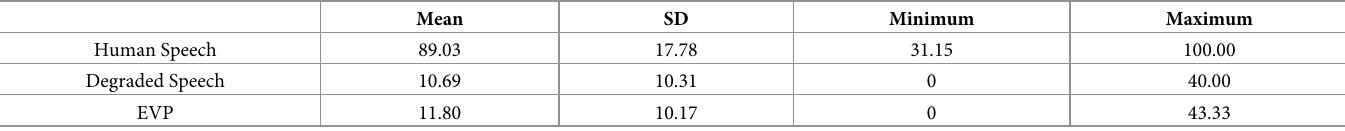
Table 2. Descriptive statistics for the maximum agreement of the spoken word content per